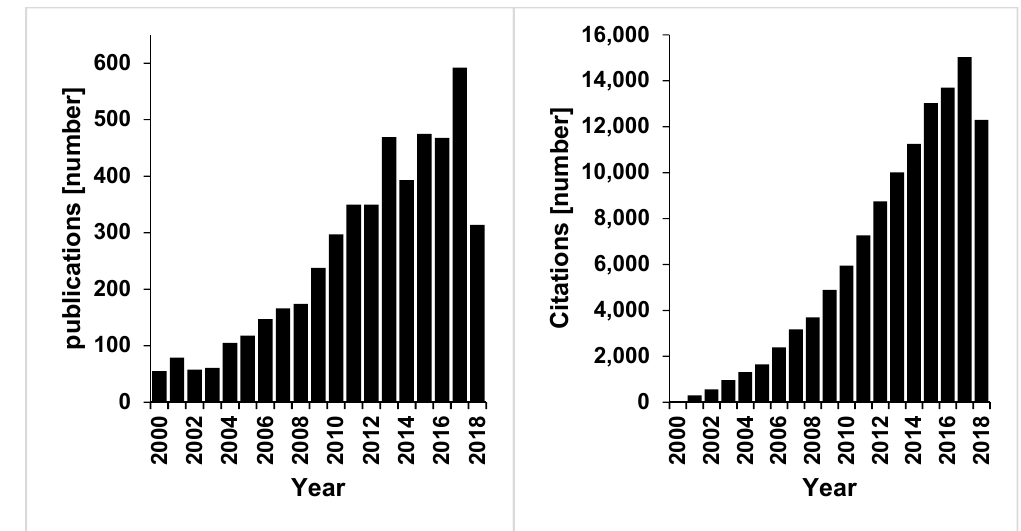
Figure 1. Web of Science search illustrating the increase in research activity in the field of glycovirolgy from 2000 to now (search terms: TOPIC: glycan AND TOPIC: virus). Left: Number of publications; right: Number of citations. Databases searched: WOS, BCI, CCC, DRCI, DIIDW, KJD, MEDLINE, RSCI, SCIELO, ZOOREC.